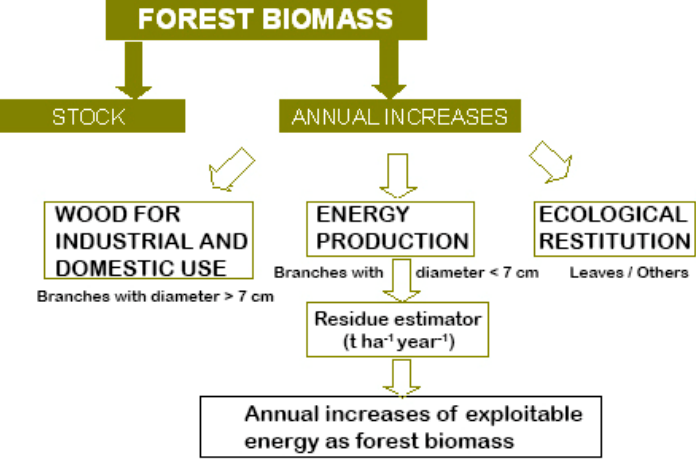
Figure 3. Destinations of forest biomass wastes.